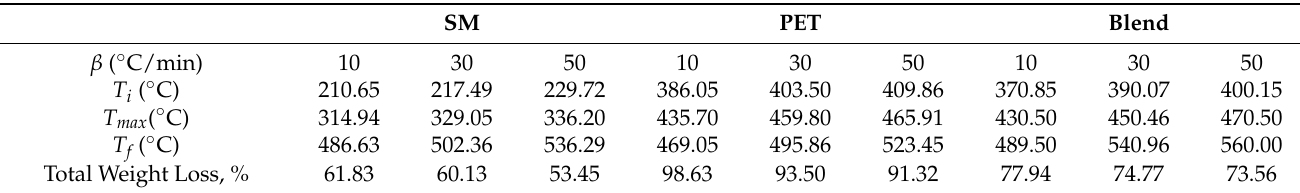
Table 2. Characteristic temperatures of